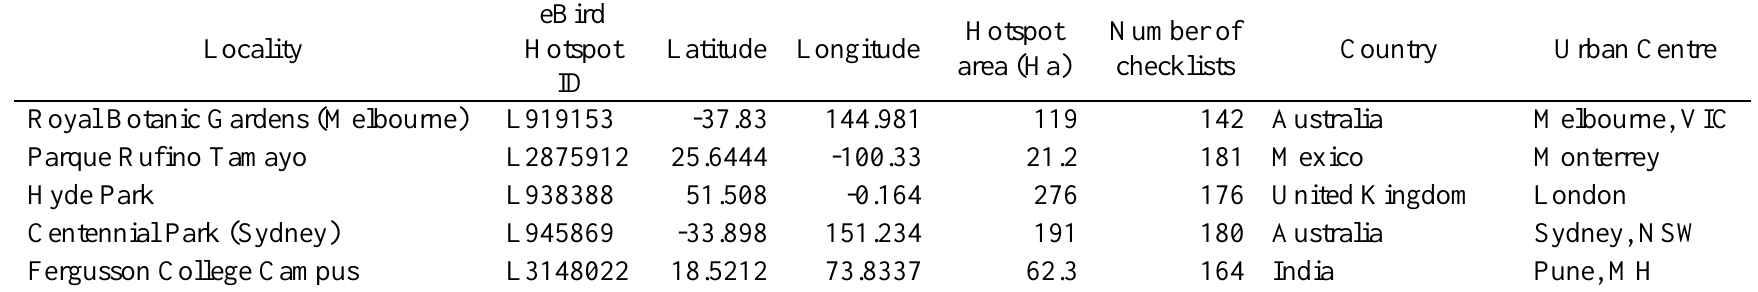
Table A1.2. The five global greenspaces that met the specified criteria, which were analysed and then compared with the North American